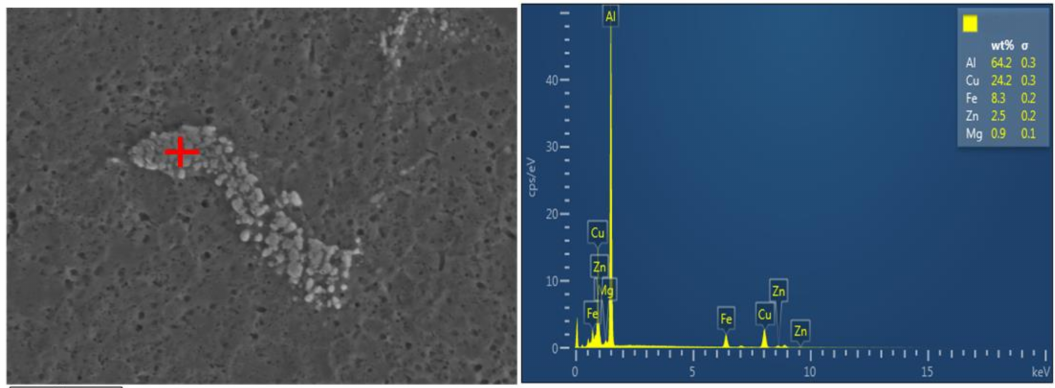
Figure 3. Energy dispersive spectroscopy (EDS) analysis results of the coarse secondary phase.